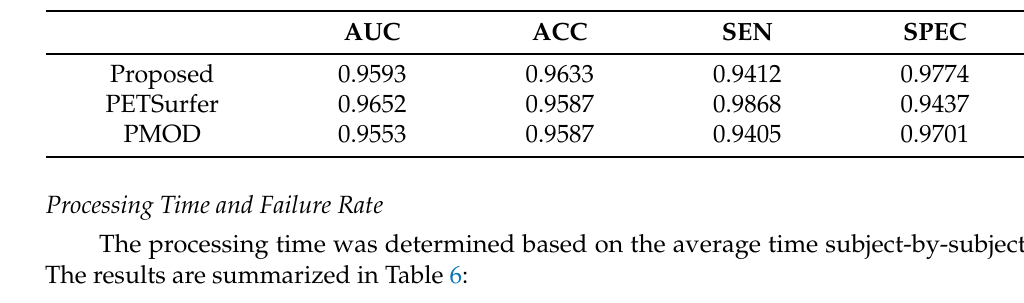
Table 5. Classification results of three tools. ACC, SEN, and SPEC denote accuracy, sensitivity, and specificity, respectively.